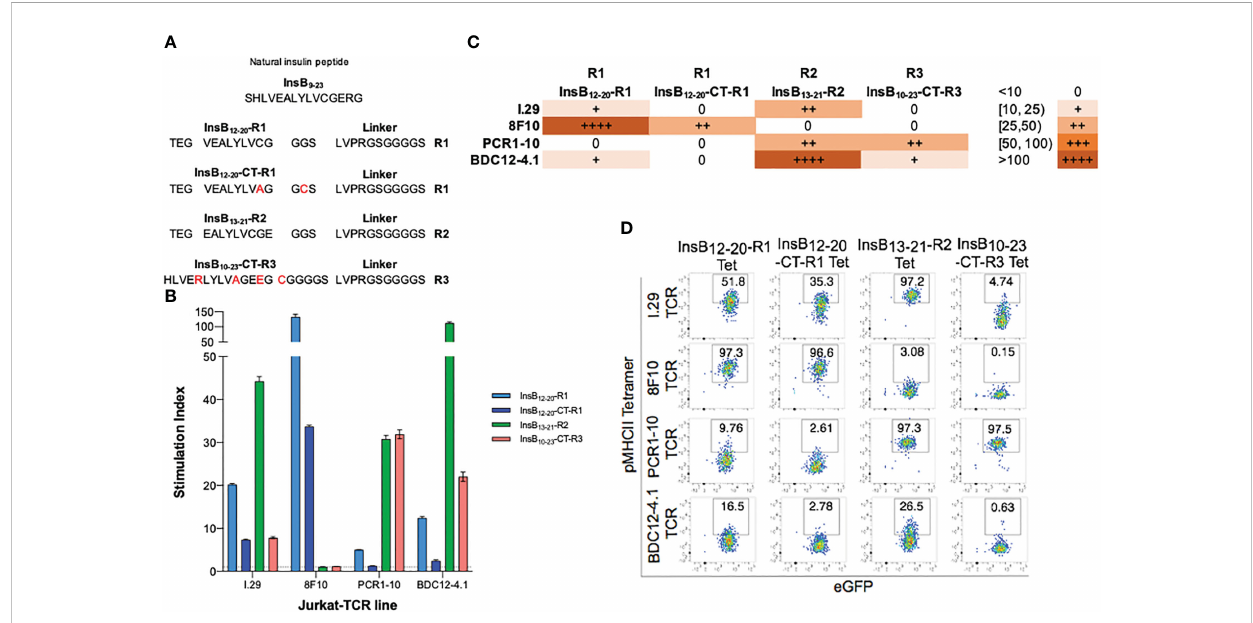
FIGURE 1 Reactivity patterns of four different InsulinB 9-23 /IA g7 pMHCIIs to reporter Jurkat cell lines expressing cognate TCRs. (A) Peptide-linker sequences of InsulinB 9-23 bound to IA g7 on different registers. (B) NFAT-driven luciferase activity of four different TCR transfectants to plate-bound pMHCII monomers. Data are shown as the average ± S.E. from triplicate cultures. (C) Summary of the differential agonistic activity of the different pMHCIIs on the 4 different Jurkat cell lines from (B) . (D) Binding of the four pMHCII tetramers from (A) to the Jurkat cell lines used in (B)